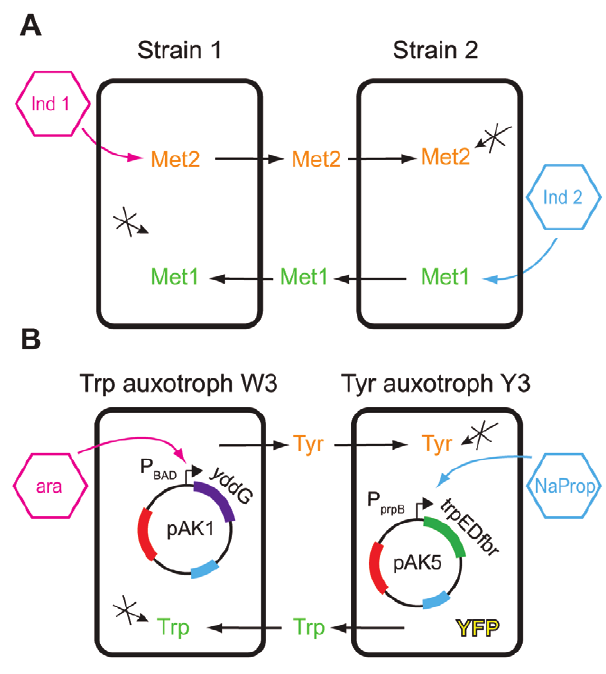
Figure 1. Basic schematic of the tunable cross-feeding circuit. ( A ) In this general design, inducer 1 and inducer 2 control the export of metabolites 1 and 2, respectively. The two auxotrophs must cross-feed in order to survive in the minimal medium. ( B ) In our specific implementation, two E. coli auxotrophic strains exchange tryptophan (Trp) and tyrosine (Tyr). The forced symbiosis is controlled by plasmids pAK1 (in the Trp auxotroph, W3) and pAK5 (in the Tyr auxotroph, Y3). Plasmid pAK1 contains gene yddG behind the tunable promoter P BAD , and pAK5 contains trpEDfbr behind P prpB (Methods). Strain Y3 is tagged with yellow fluorescent protein (YFP).